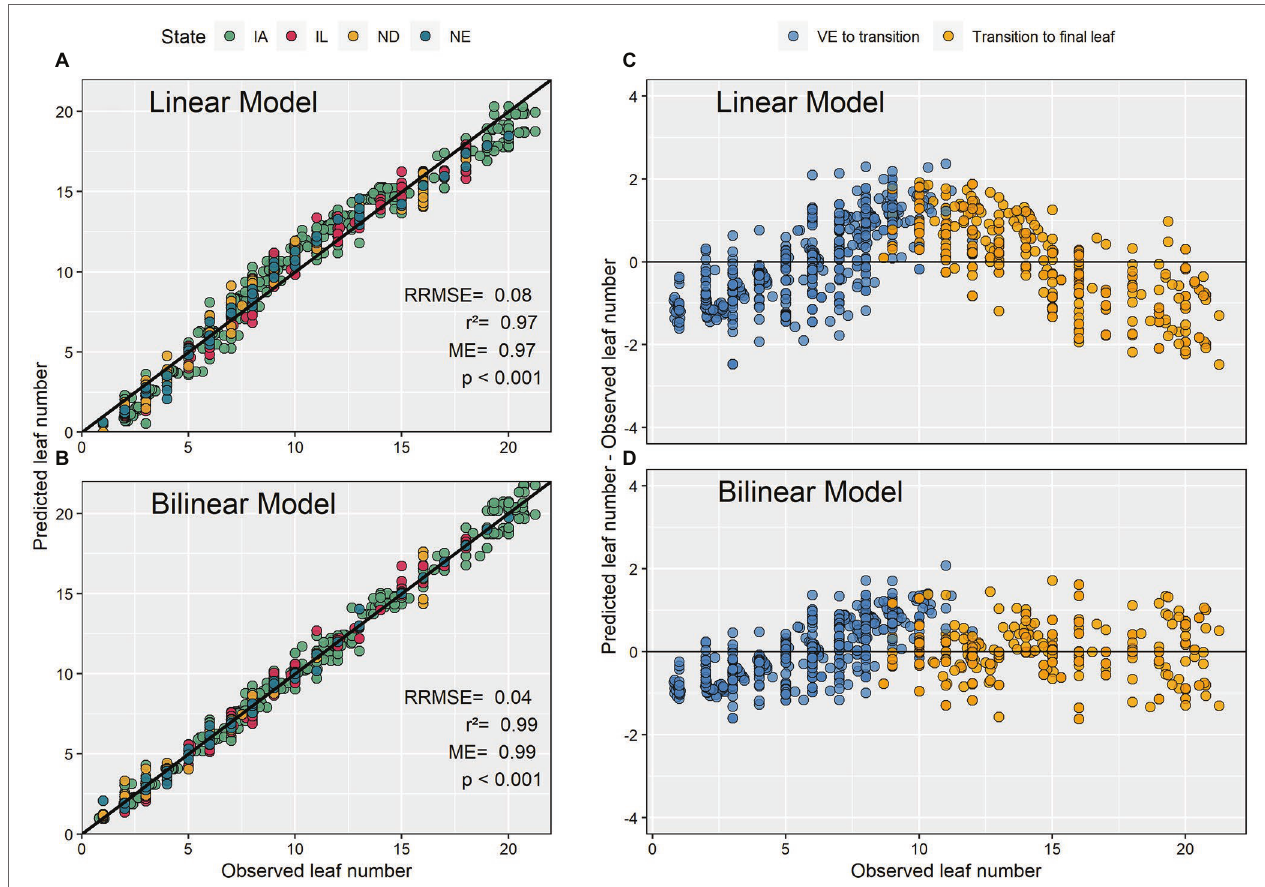
FIGURE 4 | Predicted and observed maize leaf numbers using linear and bilinear models (A,B) and their associated residual plots (C,D)